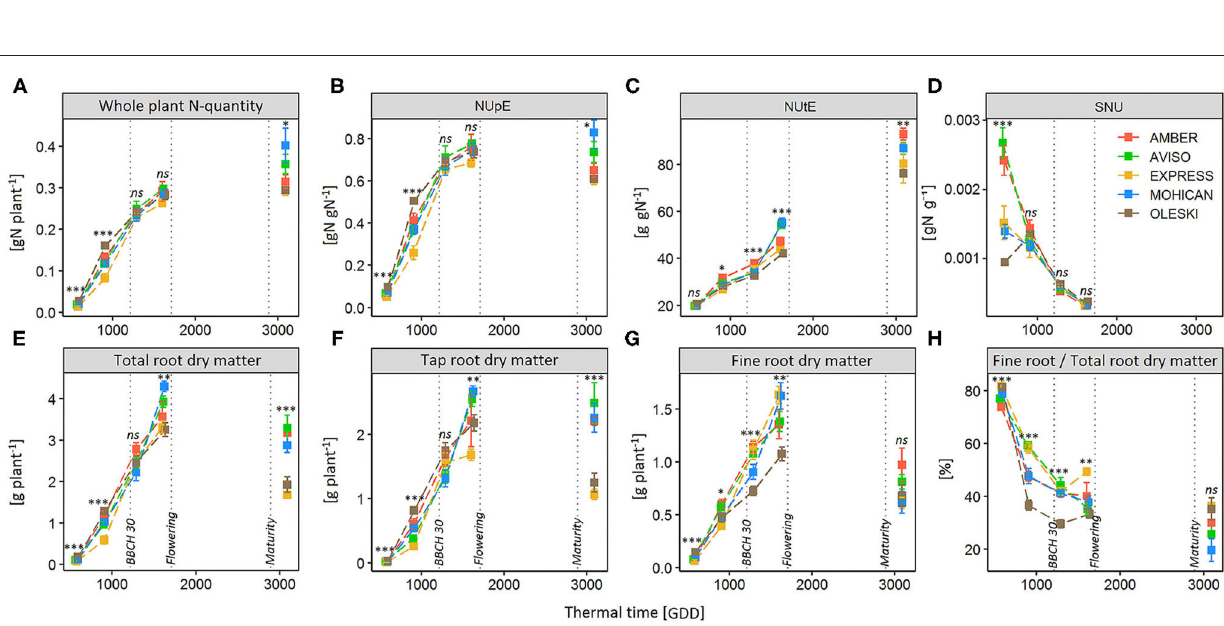
Frontiers in Plant Science |